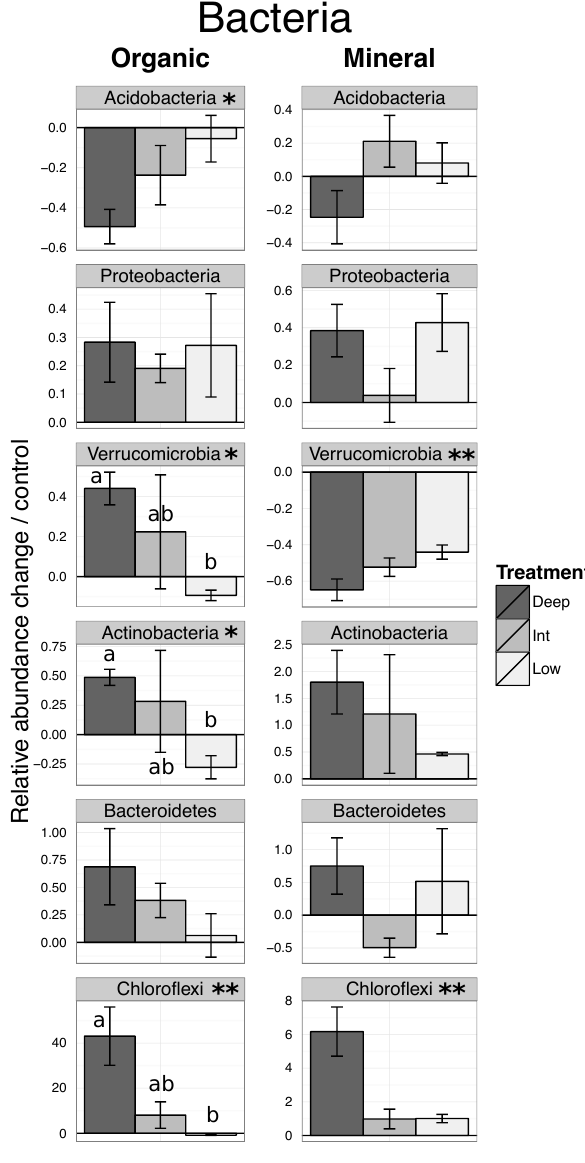
Figure 3. Averaged relative abundance of the six most abundant bacterial phylum relative to the control, separated by snow accumu- lation treatment, and in order of greatest abundance (top to bottom panels). Error bars represent standard error (standard error of con- trols ranged from 12.929 in Chloroflexi to 0.026 in Verrucomicro- bia). Significance determined by Kruskal–Wallis tests is indicated by asterisks ( ∗ = p < 0.1, ∗∗ = p < 0.05), while post hoc Nemenyi test results are indicated by “a”, “b”, or “ab”, except where there were significant differences to the control.